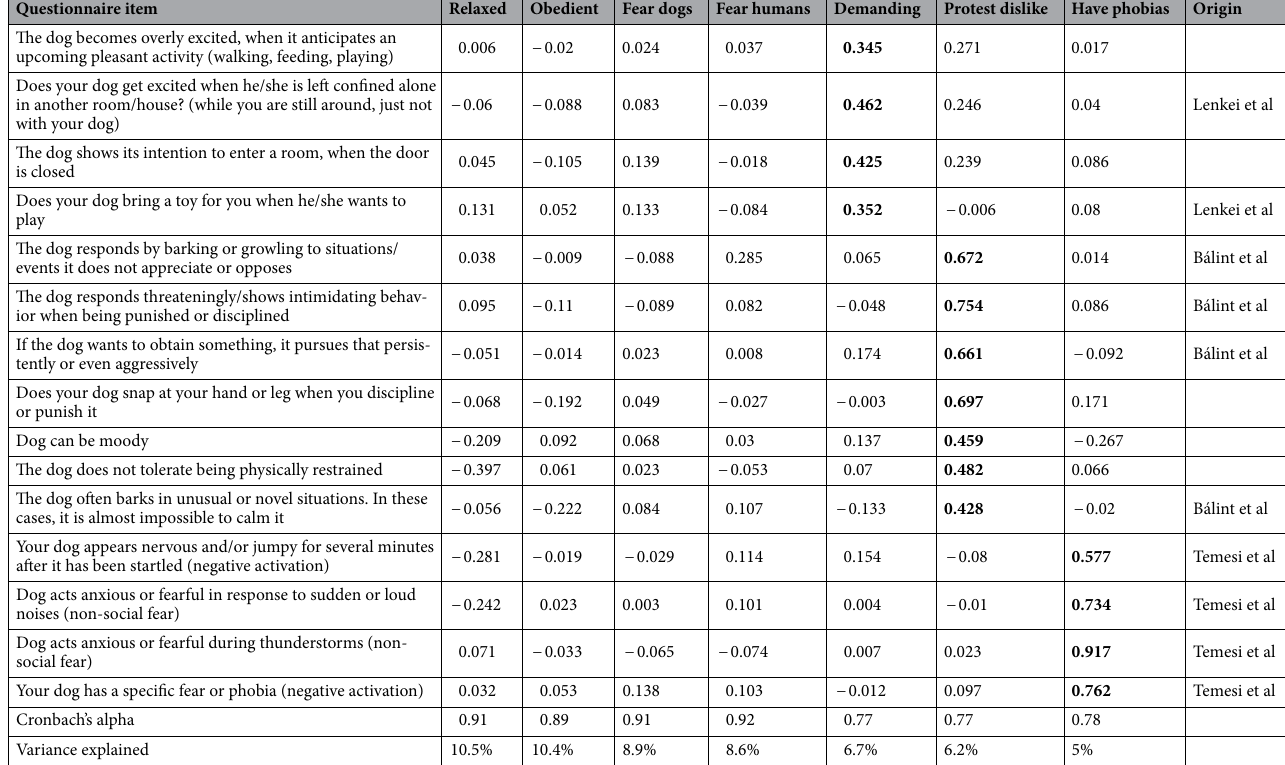
Table 1. The results of the principal component analysis of the questionnaire (N = 392). In case of each principal component, we highlighted the loading of those items with bold that significantly contributed to